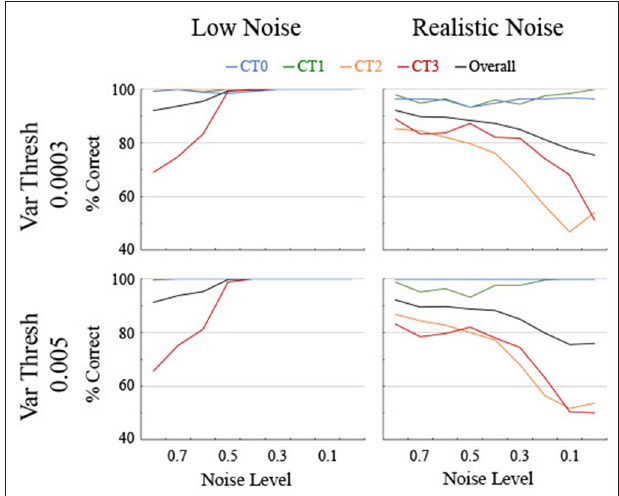
FIGURE 7 | Classification accuracy as a function of noise level, shown separately for low and realistic noise levels and two levels of variance threshold. Percent correct of 250 trials per data point is shown for the four different curve types along with the overall percent correct across curve types. Chance is at